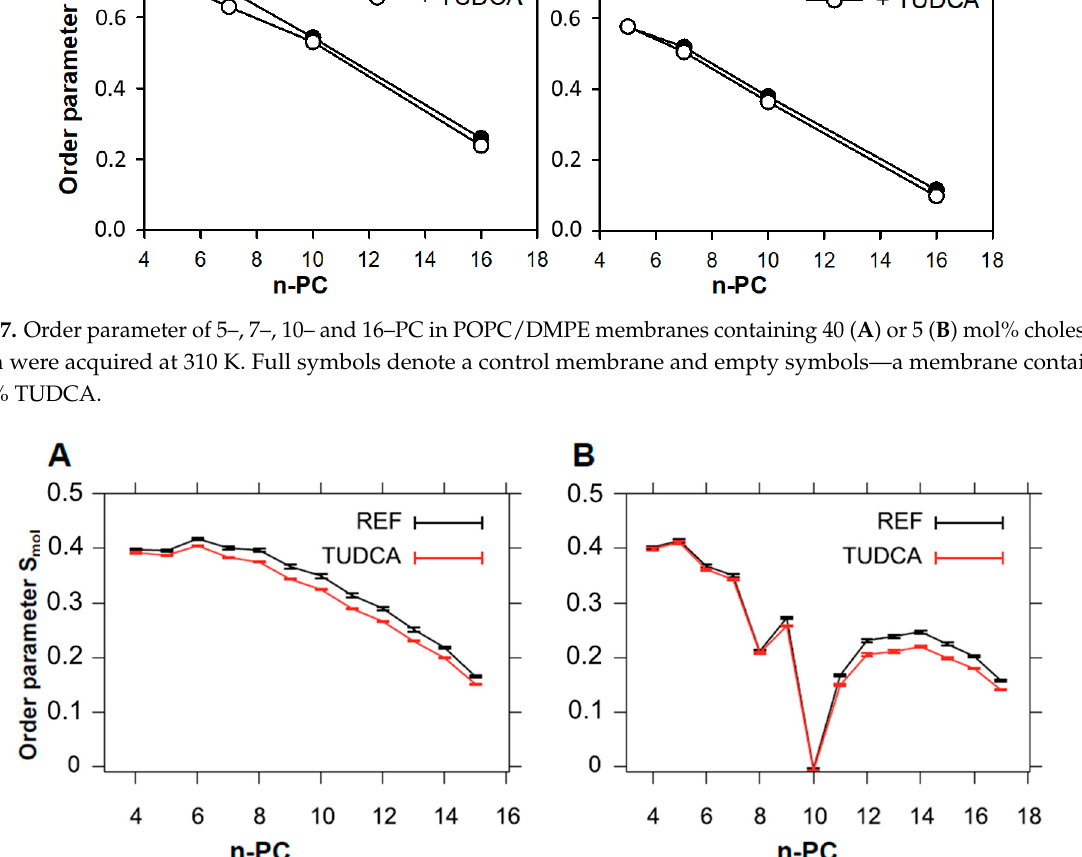
Figure 8. Molecular order parameter (S mol ) calculated for POPC alone (REF) and in the presence of TUDCA (TUDCA) plotted against the carbon number in the alkyl chain. S mol parameter was calculated for palmitic acid chain esterified in sn1 position ( A ) and for oleic acid chain esterified in the sn2 position ( B ) separately.